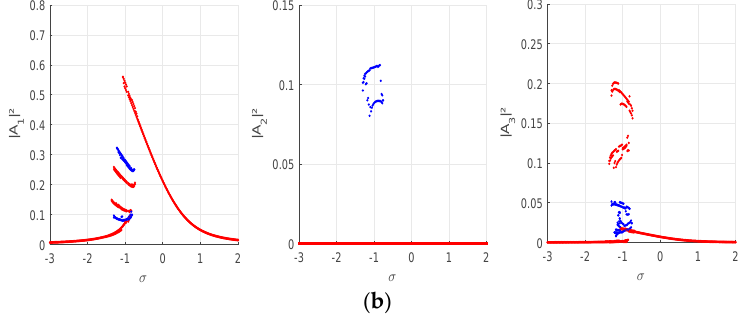
Figure 13. Envelopes of the modal intensity amplitude responses: ( a ) (cid:3627)(cid:1827)(cid:4634) (cid:2869) (cid:3627) first pendulum and ( b ) |(cid:1827) (cid:2869) | (cid:2870) , |(cid:1827) (cid:2870) | (cid:2870) and |(cid:1827) (cid:2871) | (cid:2870) of the second pendulum, computed using the gPCE method for (cid:2012) (cid:3039) = 2% .